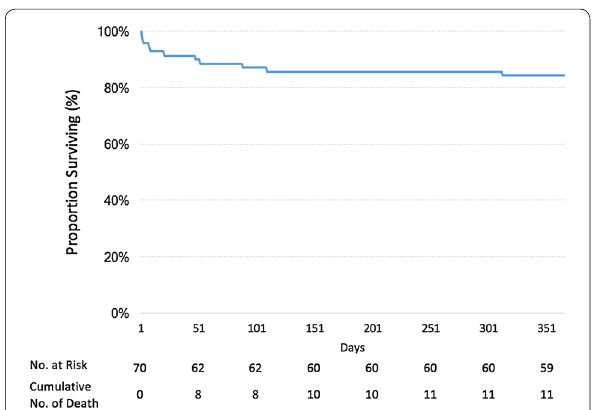
Fig. 1 Kaplan–Meier curve for cumulative